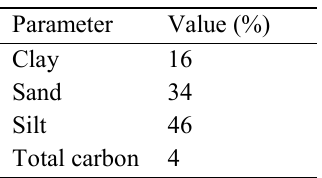
Table1. Properties of soil samples used in this